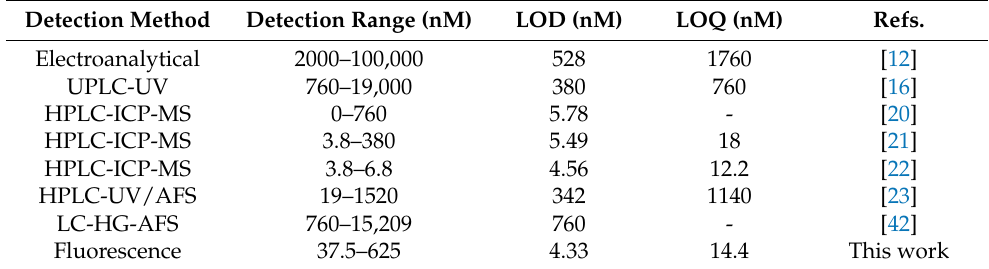
Figure 7. The fluorescence spectra of MIPs@Mn-ZnS QDs ( a ) and NIPs@Mn-ZnS QDs ( b ) in the presence of different concentrations of ROX. The linear calibration graph of MIPs@Mn-ZnS QDs and NIPs@Mn-ZnS QDs ( c ) in the presence of ROX. Table 1. Comparison of the proposed method with the other reported methods for determination of ROX *.